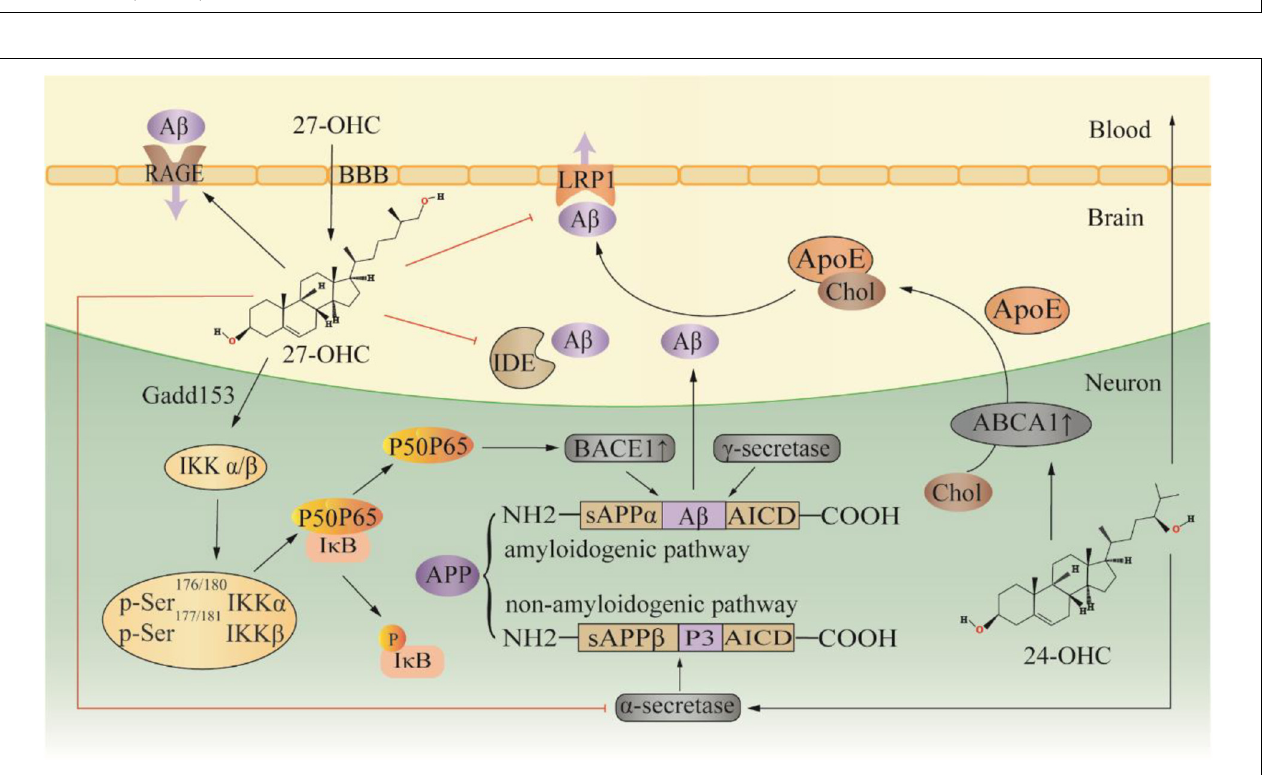
FIGURE 2 | Effect of 27-OHC on A β production and elimination. 24-OHC, 24 (S) -hydroxycholesterol; 27-OHC, 27-hydroxycholesterol; ABCA1, ATP-binding cassette A1; ApoE, apolipoprotein E; APP, amyloid precursor protein; BBB, blood-brain barrier; Chol, cholesterol; Gadd153, growth arrest and DNA damage-induced gene 153; IDE, insulin-degrading enzyme; LRP1, LDL receptor-like protein 1; and RAGE, receptor for advanced glycation end products.